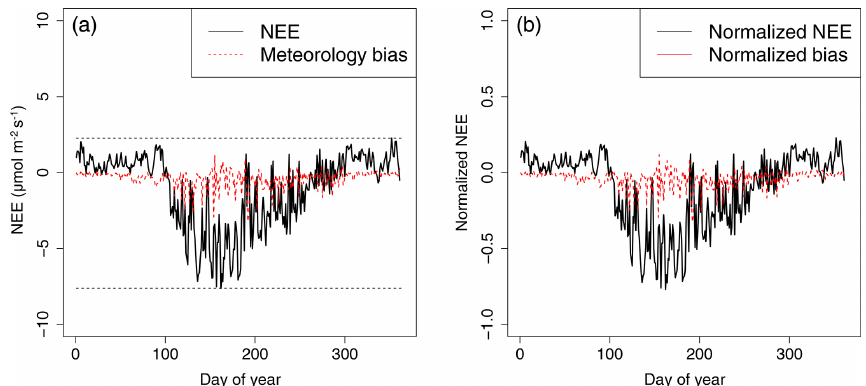
Figure 2. Example of the data normalization at station BE-Bra: (a) NEE output from simulation (a) and the corresponding Bias NEE . The dashed black lines show the range of annual NEE. (b) NEE and bias after normalization by the range, conserving the physical meaning (release and uptake) of the sign. Table 3. Normalized mean absolute error (MAE) of NEE for each error source. The compared objects are simulations (a) to (f), the reference simulation (ref.) and FLUXNET observation (obs.). Error sources (1) to (6) described in Sect. 2.2 can be isolated by calculating the MAE between different